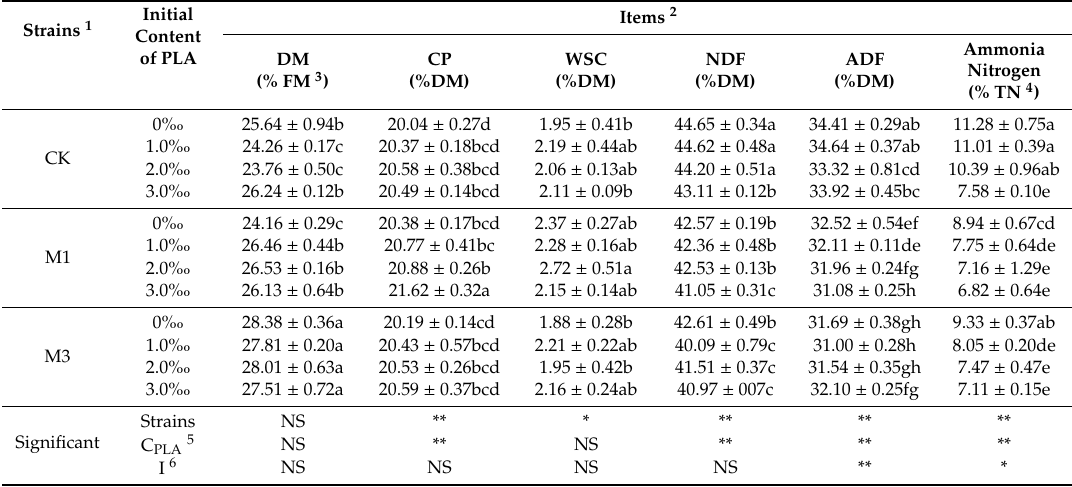
Table 4. E ff ect of lactobacillus bacteria and phenyllactic acid on the nutrition characteristics and concentrations of structural carbohydrates in alfalfa